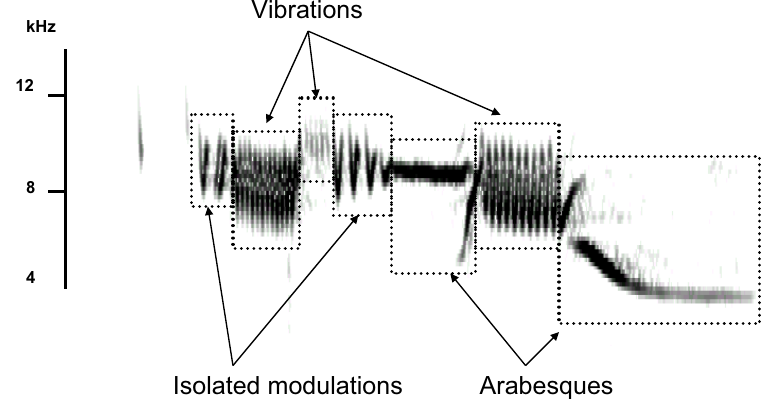
Fig. 4 – The three types of Blocks that represent the main song components: Vibrations, Arabesques and Isolated